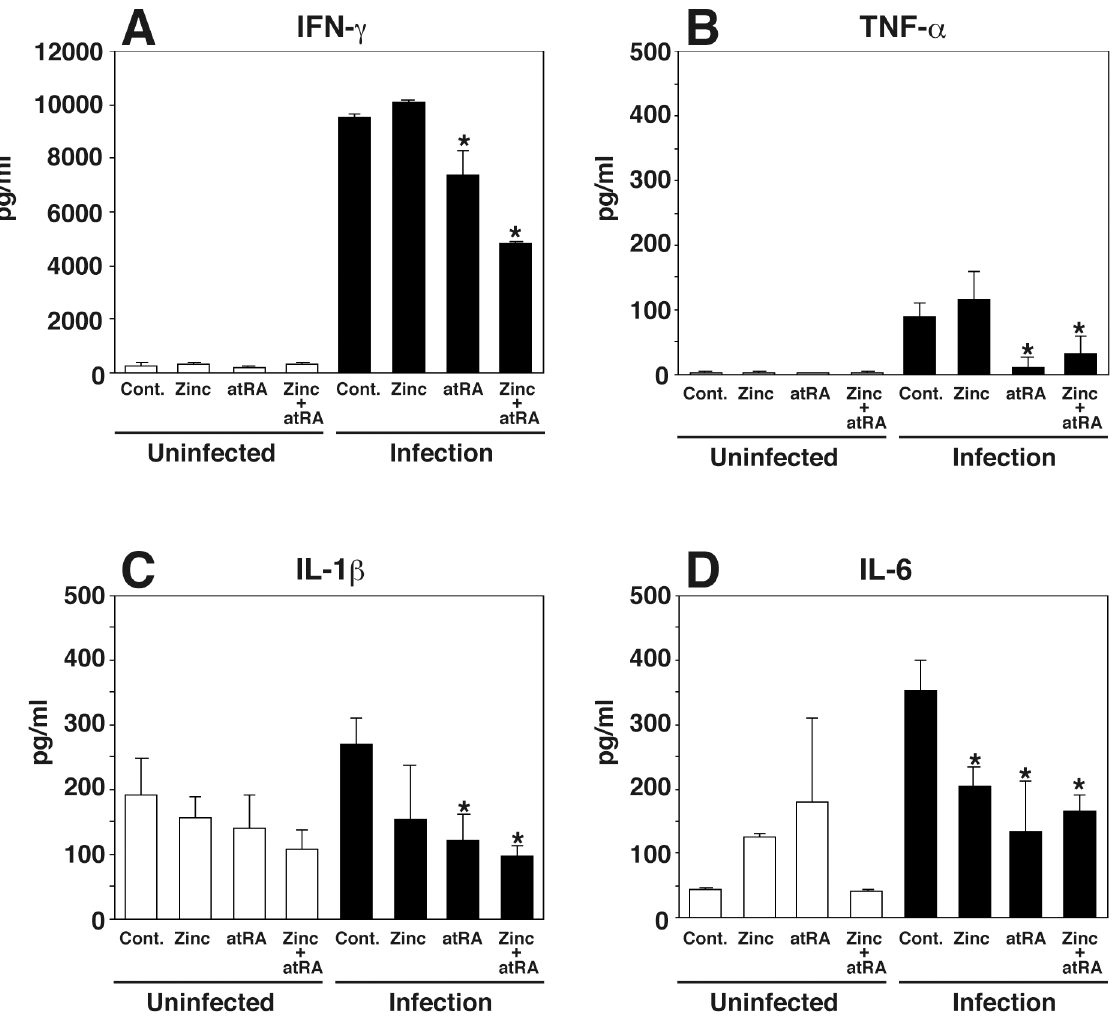
Fig 3. Cytokine levels in normal and L . monocytogenes -infected mice supplemented with Zn, atRA, or a combination of both. Doses were given intraperitoneally for 7 intradays and 6 consecutive days, respectively (Fig 1A). Twenty-four hours after the last dose, the mice were infected intravenously with 10 4 /100 μ l L . monocytogenes per mouse. IFN- γ , TNF- α , IL-1 β , and IL-6 were measured using an ELISA 48 h post-infection. Experiment was performed three times with four mice per group each time. Control mice received corn oil (atRA) or PBS (Zn) alone. Data are mean ± SD values of 12 mice per group. Statistically significant differences, compared with the control, are indicated by